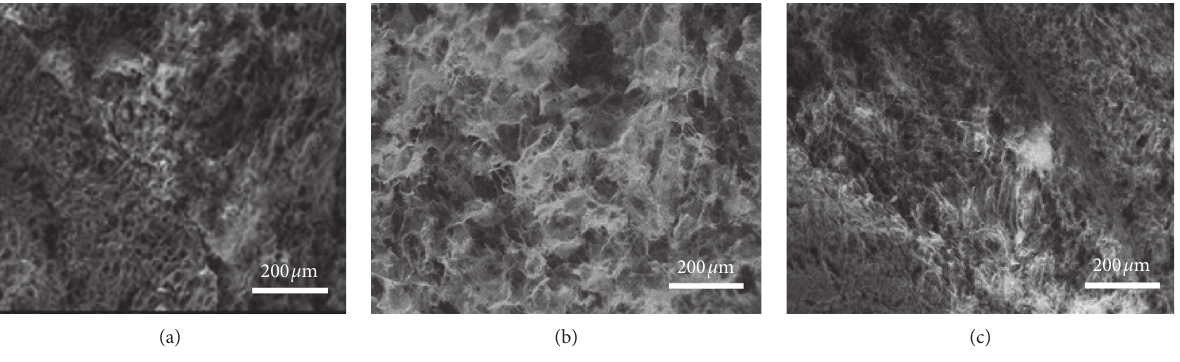
Figure 2: SEM images of MFC cryogels loaded with chitosan (CH) of 0% (a), 10% (b), and 20% (c).